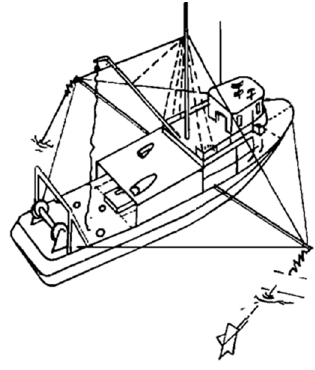
Figure 5. Innovations to mitigate musculoskeletal risk in crab harvesting when lifting pots with a ramp and boom. Courtesy of Gary A. Mirka, Iowa State University.